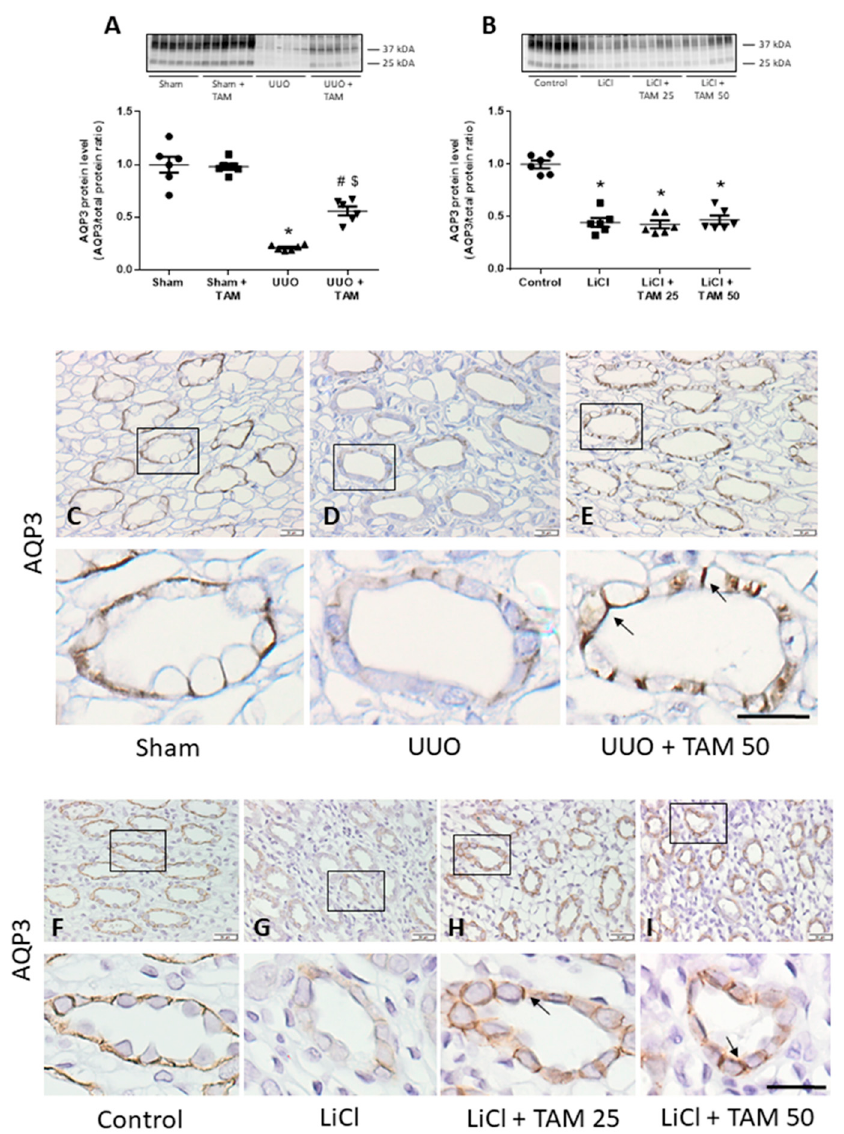
Figure 1. TAM rescues AQP3 expression and affects subcellular localization in both UUO and lithium-induced NDI rats. Western blot analysis revealing the impact of TAM treatment on AQP3 protein expression, relative to total protein, in ( A ) UUO rats and ( B ) LiCl-treated rats. Data are presented as mean ± SEM (n = 6 per group). * p < 0.05 compared to sham or control; # p < 0.05 compared to UUO and $ p < 0.05 compared to sham + TAM. ( C – E ) Representative immunohistochemistry images of AQP3 expression in collecting ducts in ( C ) sham rats, ( D ) UUO rats, and ( E ) UUO rats treated with TAM 50 mg/kg (n = 4 per group). ( F – I ) Representative immunohistochemistry images of AQP3 expression in ( F ) control rats, ( G ) LiCl-treated rats, and LiCl-treated rats treated with ( H ) TAM 25 mg/kg or ( I ) TAM 50 mg/kg (n = 4 per group). Below shows the insert. Scale bar 20 µm. Arrows indicate lateral and apical AQP3 labeling.